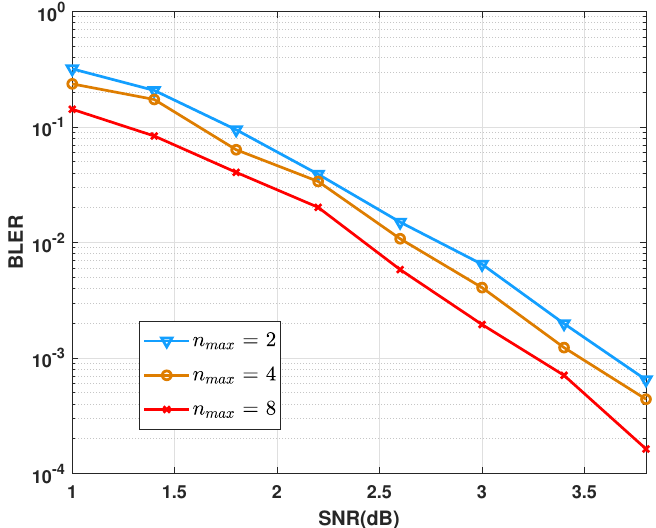
Figure 10. BLER comparison of IBPL decoder under different number of maximum decoding paths when the code length is 128 bits and code rate is